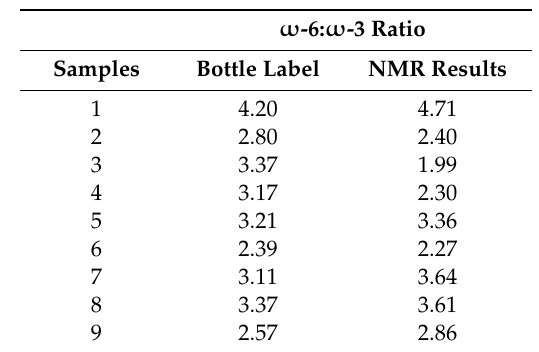
Table 4. Comparison between ω-6:ω-3 ratios reported on the bottle labels and the ones measured by NMR analysis. Integrals of signals D (diallylic protons of linoleic fatty chains at 2.729 ppm) and E (diallylic protons of linolenic fatty chains at 2.778 ppm) of the nine commercial hemp seed oils analyzed were measured.